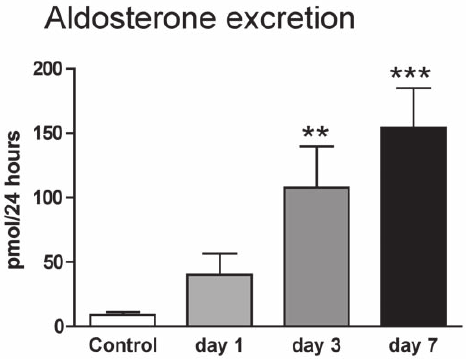
Figure 3. 24-hour urinary excretion of aldosterone. Urine was collected from conscious cyp1a1-Ren2 transgenic rats (n=8) maintained in individual metabolism cages, over consecutive days of transgene induction. Data are mean 6 SE. Statistical comparisons were made using ANOVA with Bonferroni post-test. ***P , 0.001, **P , 0.01 versus the control